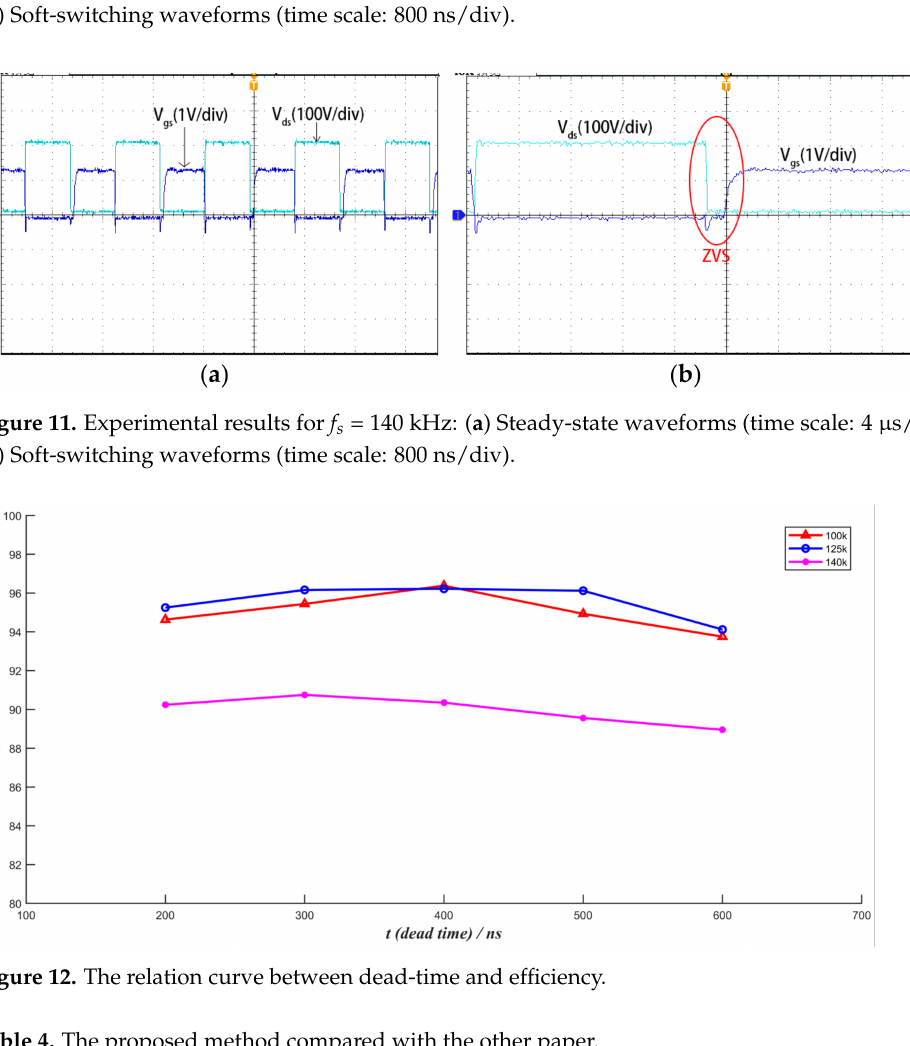
Figure 10. Experimental results for f s = 125 kHz: ( a ) Steady-state waveforms (time scale: 2 µ s/div);